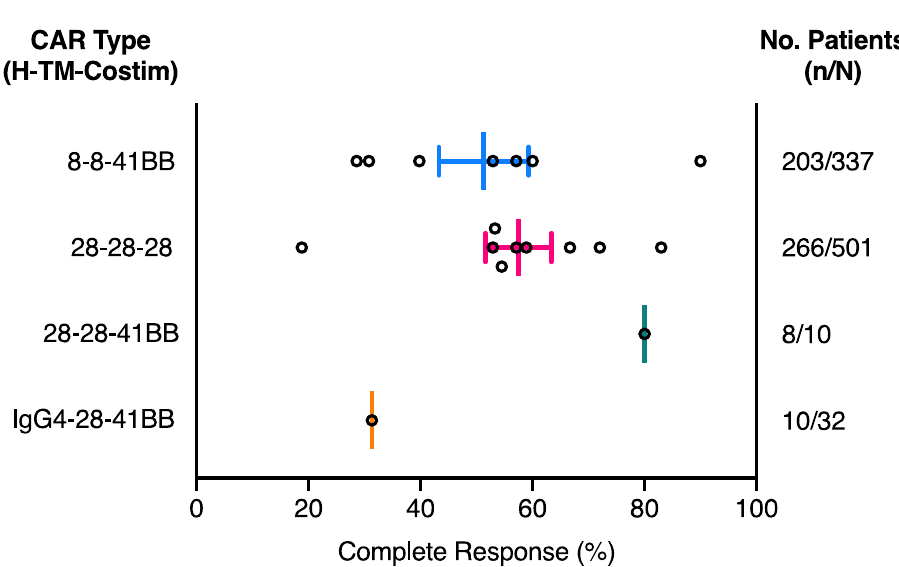
Figure 2. Effect of CAR composition on complete response in patients treated with CD19 CAR-T cell therapy. CAR type separated based on hinge (H), transmembrane (TM) and costimulatory (Costim) domain composition. All CAR constructs use the FMC63 anti-CD19 scFv and the CD3 ζ -chain activation domain. Each circle represents an individual clinical trial listed in Table 1. Complete response (CR) rate calculated from the number of patients who reached a CR at any stage post CAR-T cell infusion (n) as a percentage of all patients treated with the CAR-T cell therapy (N) (Table S1). Middle line represents the mean CR and error bars represent the